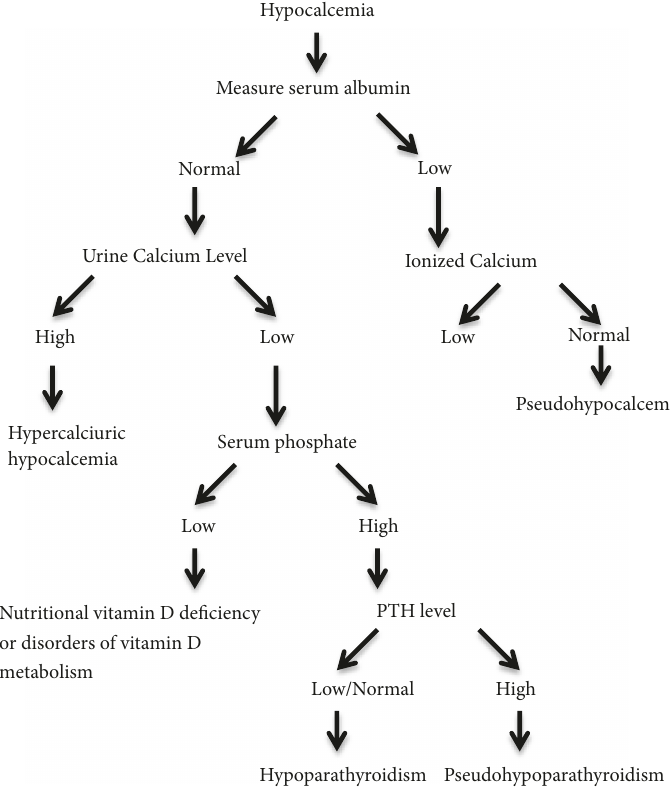
Figure 1: Diagnostic Approach to Hypocalcemia in Newborn Period and Infancy. ∗ Modified from Root AW, Diamond FB. (2008) Disorders of Mineral Homeostasis in the Newborn, Infant, Child, and Adolescent. In: Sperling MA, editor. Pediatric Endocrinology , 3rd ed. Philadelphia: Saunders/Elsevier. p.